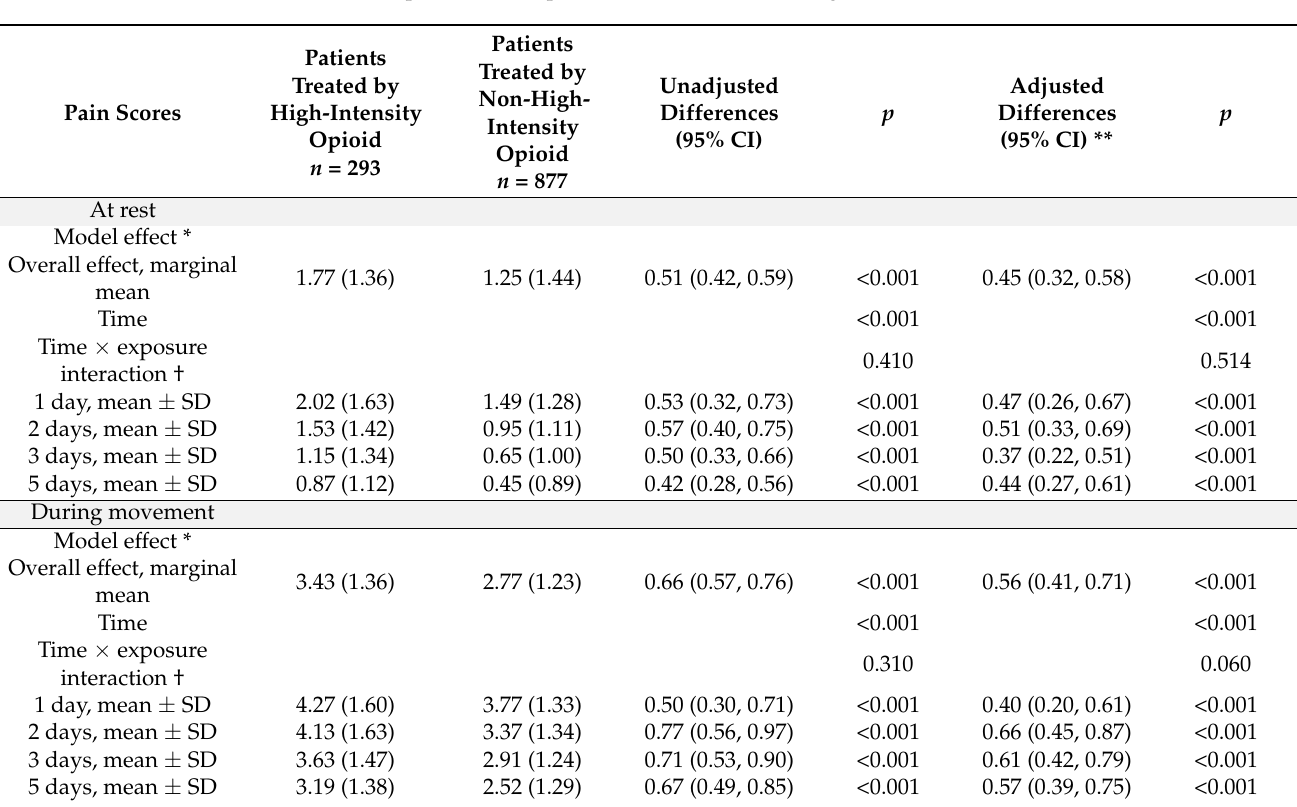
Numerical rating scale score: 0, no pain; 10, worst pain imaginable. * A generalized estimating equations model was run to compare numerical rating scale score differences between groups, with patients treated by high-intensity opioid in surgical ward (exposure) group and time (1, 2, 3, and 5 days after surgery) as fixed effects and participant as a clustering variable. † A generalized estimating equations model was run to compare numerical rating scale score differences between groups, with patients treated by high-intensity opioid in surgical ward (exposure) group and time (1, 2, 3, and 5 days after surgery) and exposure group × time interaction as fixed effects and participant as a clustering variable. ** Generalized estimating equations models were adjusted for age, sex, body mass index, preoperative analgesic and comorbidities, surgical information (i.e., the type of surgery, location of surgery, duration of surgery, anesthesia method, peripheral nerve block, local infiltration, intraoperative analgesic), and postoperative analgesic (i.e., patient-controlled intravenous analgesia or nonsteroidal anti-inflammatory agents). Abbreviations: SD, standard deviations; CI, confidence